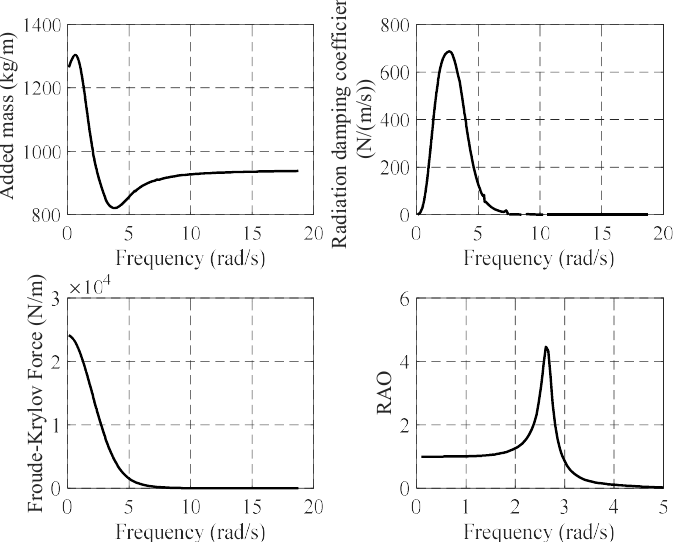
Figure 4. The added mass, radiation damping coefficient, RAO and the Froude–Krylov force coefficient of the buoy.